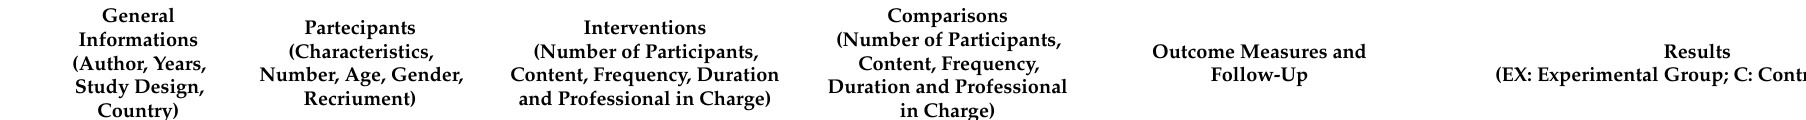
Table 1. Characteristics of the included